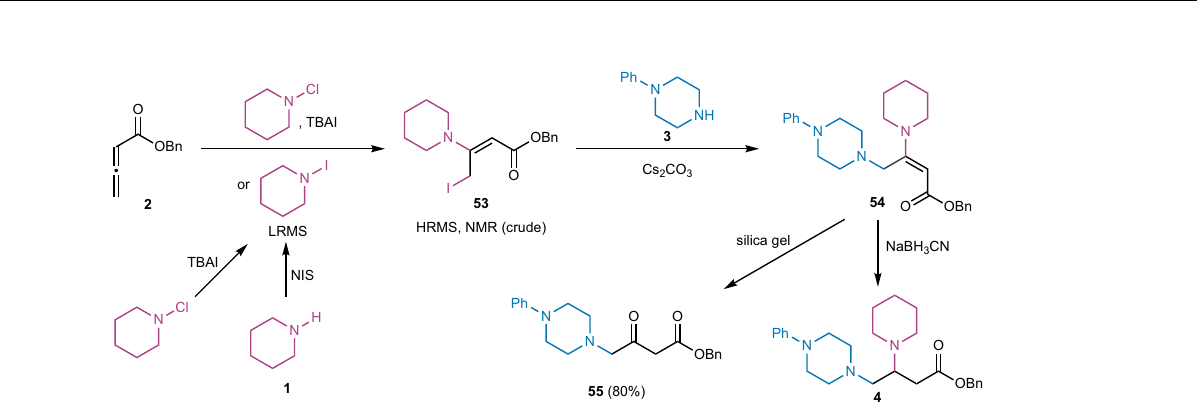
Fig. 3 | Synthetic applications. a Derivatization of FDA-approved drug molecules. b Modular synthesis. a Puri fi ed N -chloroamine was used. b Ratio was determined by 1 H NMR. d.r. Diastereomeric ratio.